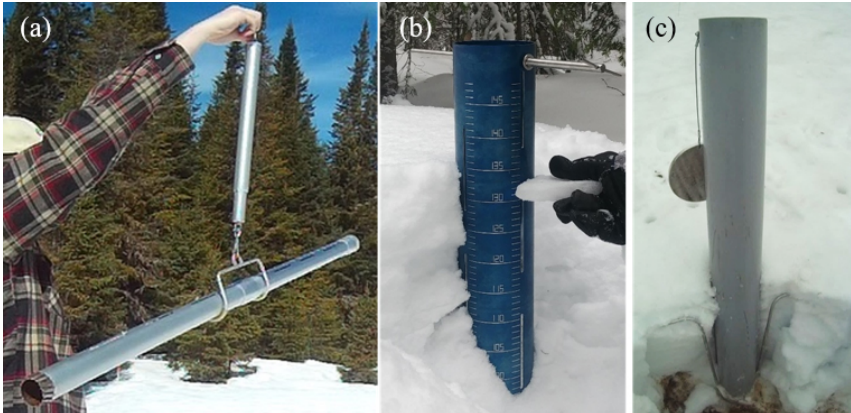
Figure 1. Snow samplers that were used in this study. From left to right: (a) Standard Federal sampler (SFS), (b) Hydro-Québec sampler (HQS), and (c) Université Laval sampler